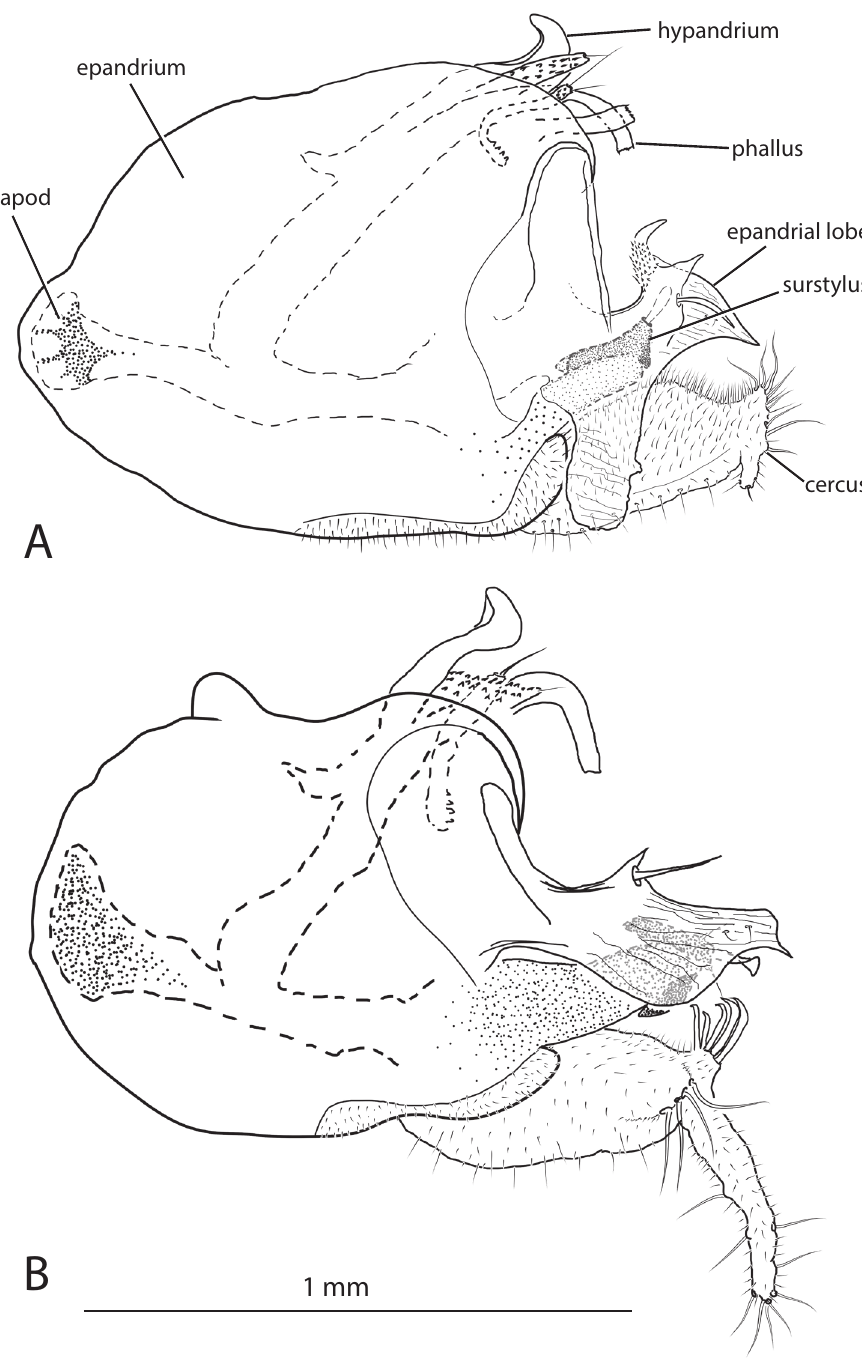
Figure 12. Liancalus male terminalia, right lateral view of A L. querulus Osten Sacken, and B L. similis Aldrich. ej apod = ejaculatory apodeme. Scale bar = 1